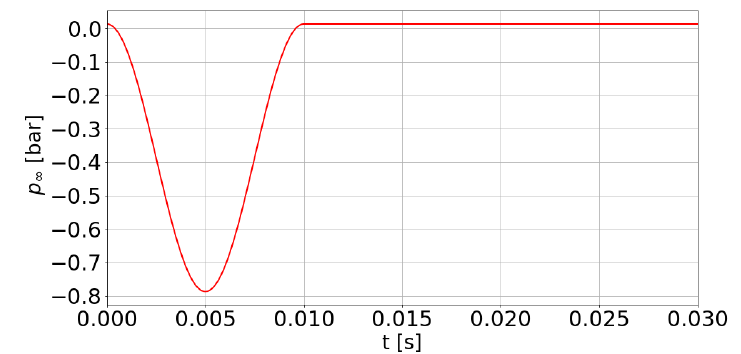
Figure 4. Pressure variation (gage pressure) forced at a distance from a spherical bubble.